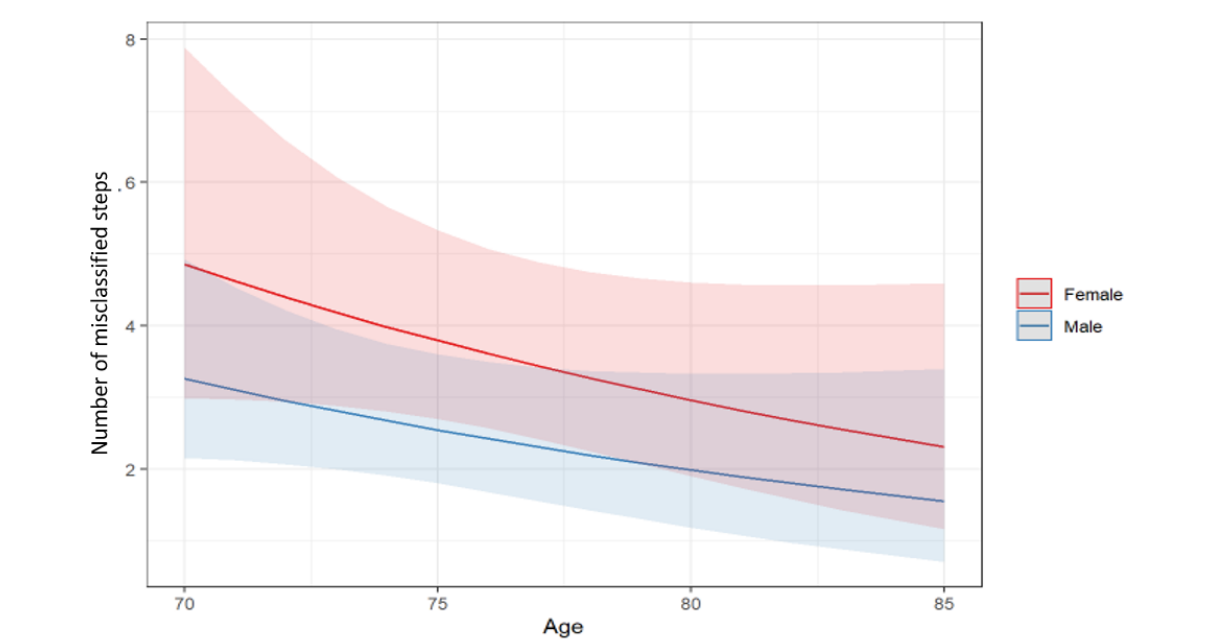
Figure 2. Negative binomial model on the number of wearable device misclassified steps in comparison with the gold standard. The model predictions for the number of misclassified steps, according to sex and age, are reported in the plots. The model estimates, misclassification rate ratio with standard errors SE, and P values are reported in the tables. A .94 misclassification rate ratio indicates a 6% reduction in the misclassification rate (over the total number of steps) for a 1-year age increase. The overdispersion estimate is 2.12 ( P <.001).